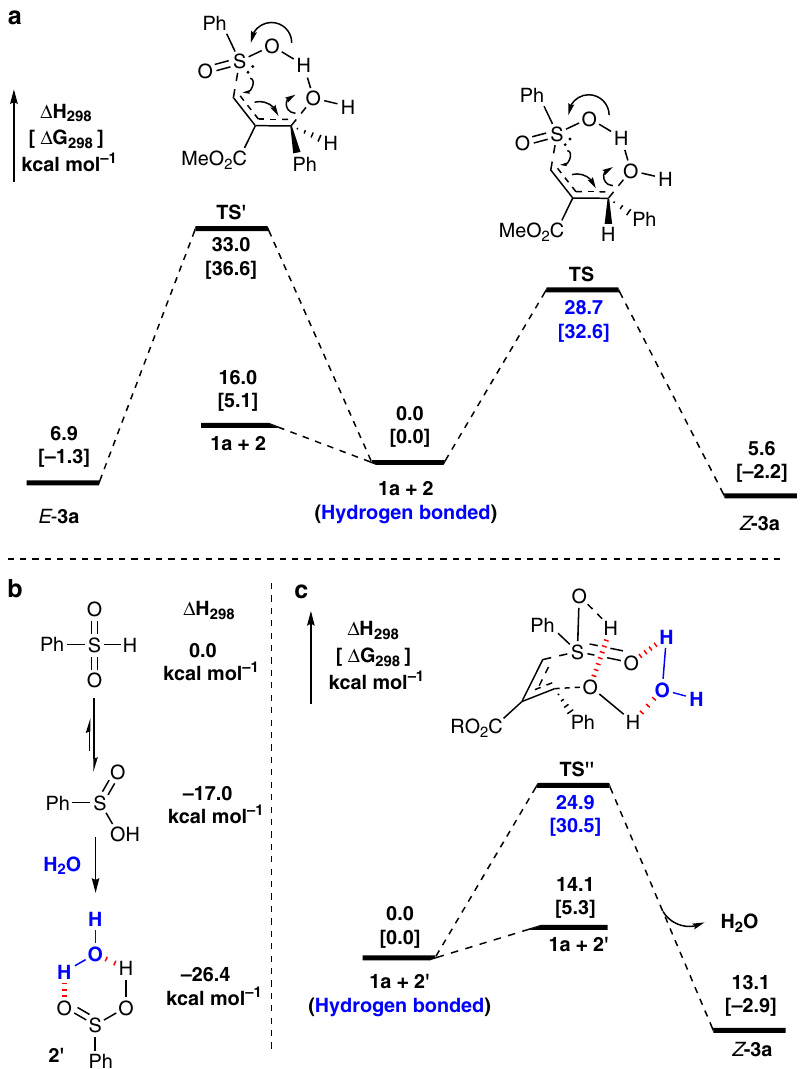
Fig. 3 B3LYP/6-31 + G(d) computed energy pro fi le for the dehydrative cross-coupling reaction. Hydrogen bonded 1 and 2/2 ′ were set as references for the 0.0 energy. a Reaction proceed through one-step process. Z -isomer is favored in energy. b Benzenesul fi nic acids can be stabilized by water forming a six- member ring format 2 ′ . c An energetically more favored bridged-ring transition states TS ″ was formed with the assistant of